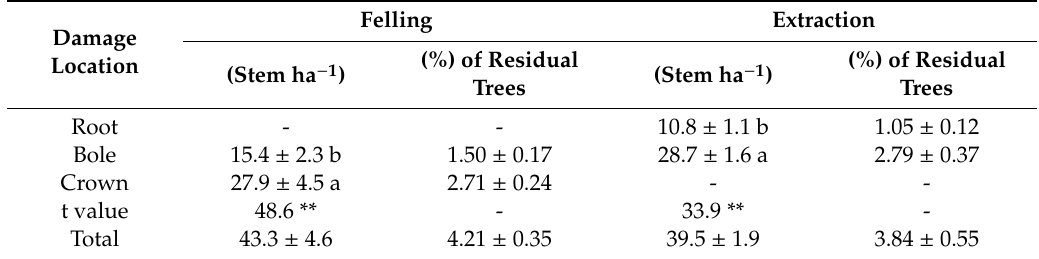
Table 2. Frequency of damage (mean ± SD) on residual trees by thinning operations (year: 2016).